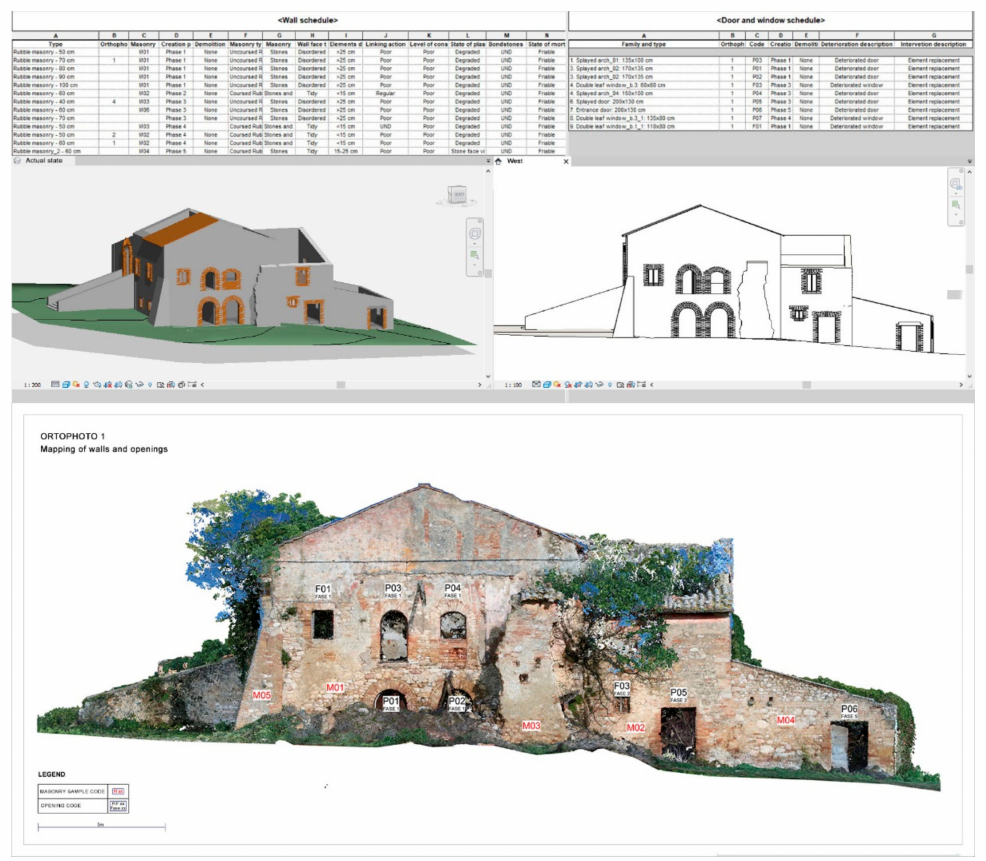
Figure 10. Views from BIM Revit software in which it is possible to note the interdisciplinary approach between descriptive alphanumeric data, three-dimensional geometric data in various configurations, and two-dimensional orthophotographic data. The data are interrelated, and the same information can be found in each configuration. The codes and images are one-to-one parameters (see Figure